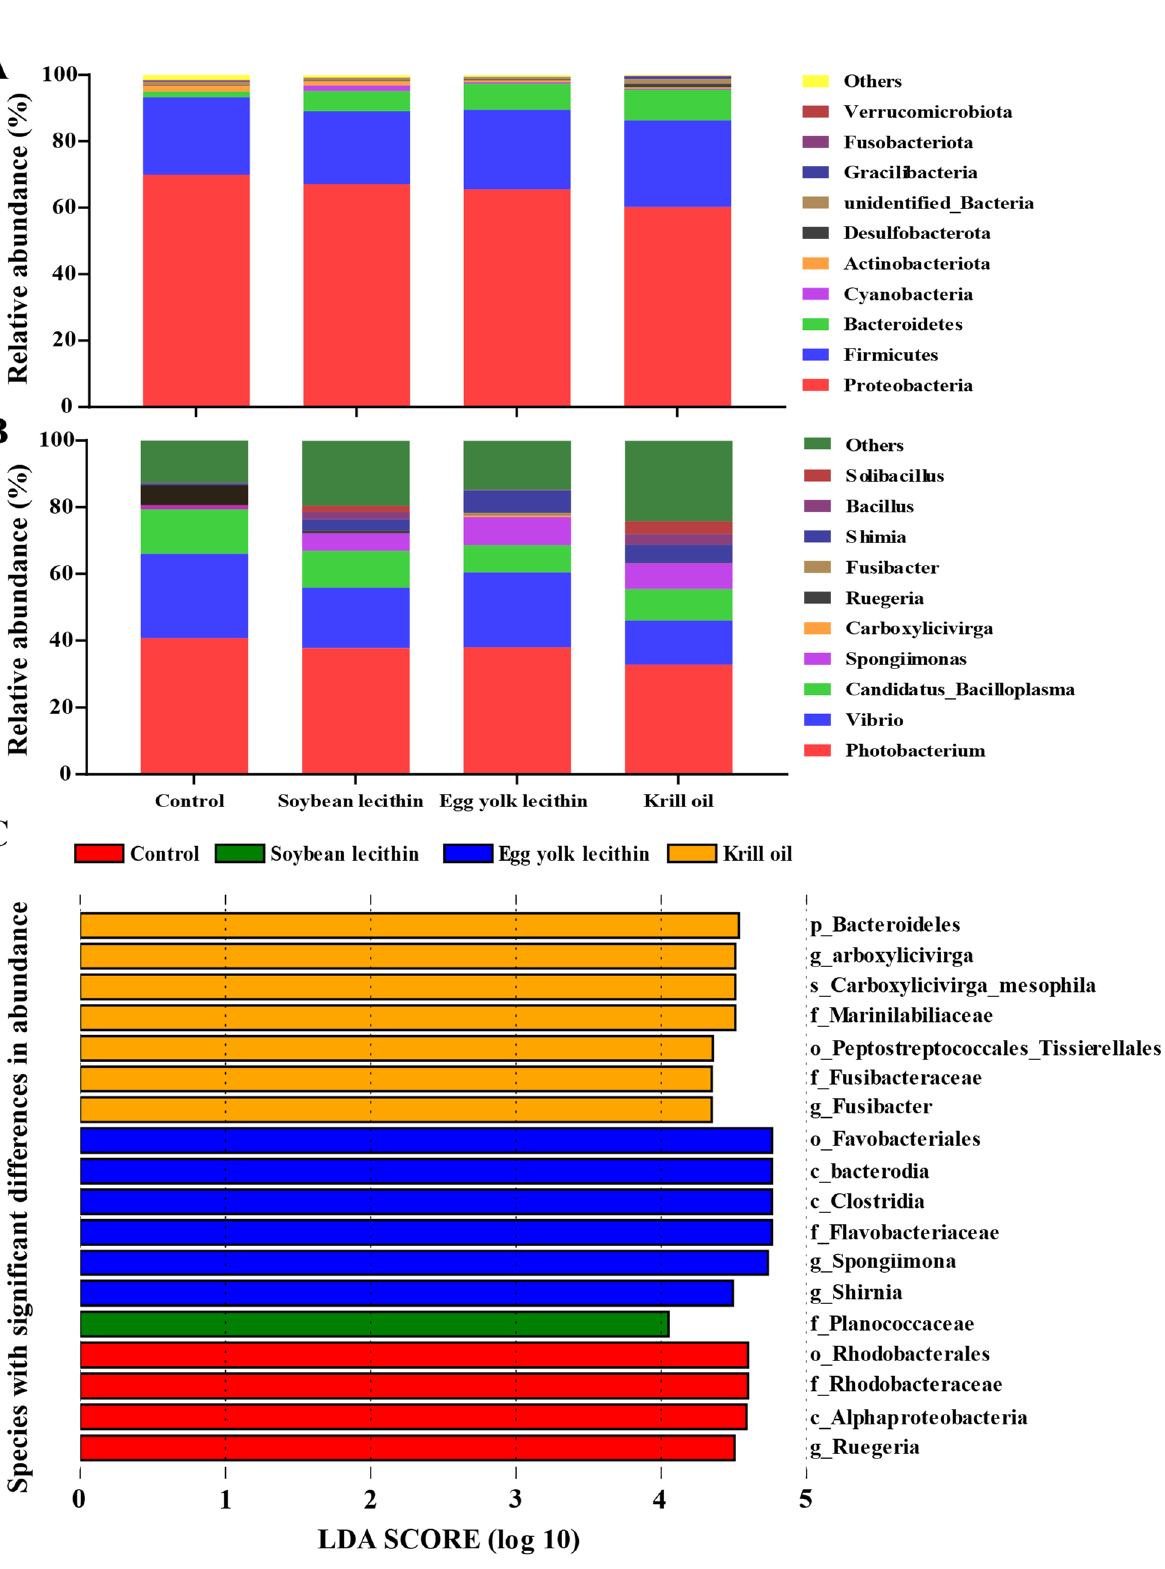
Figure 6. Gut microbial community composition of female L. vannamei fed with different phospho- lipids. Average relative abundances of dominant bacterial phyla ( A ) and genera ( B ) in the intestine. ( C ) Histogram of differentially abundant taxa identified from phylum level to genus level detected by linear discriminant analysis (LDA) effect size analysis (LEfSe; LDA > 3.5).